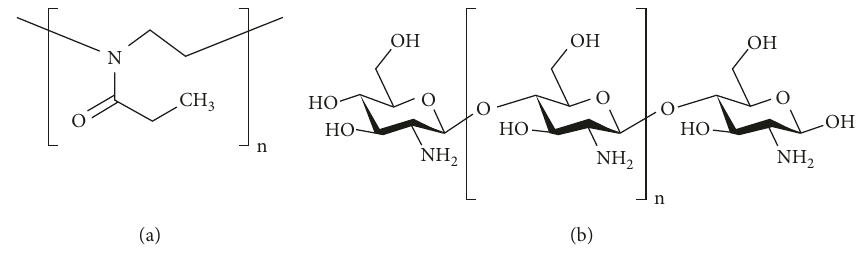
Scheme 1: Molecular structure of (a) POZ and (b) CS polymers.